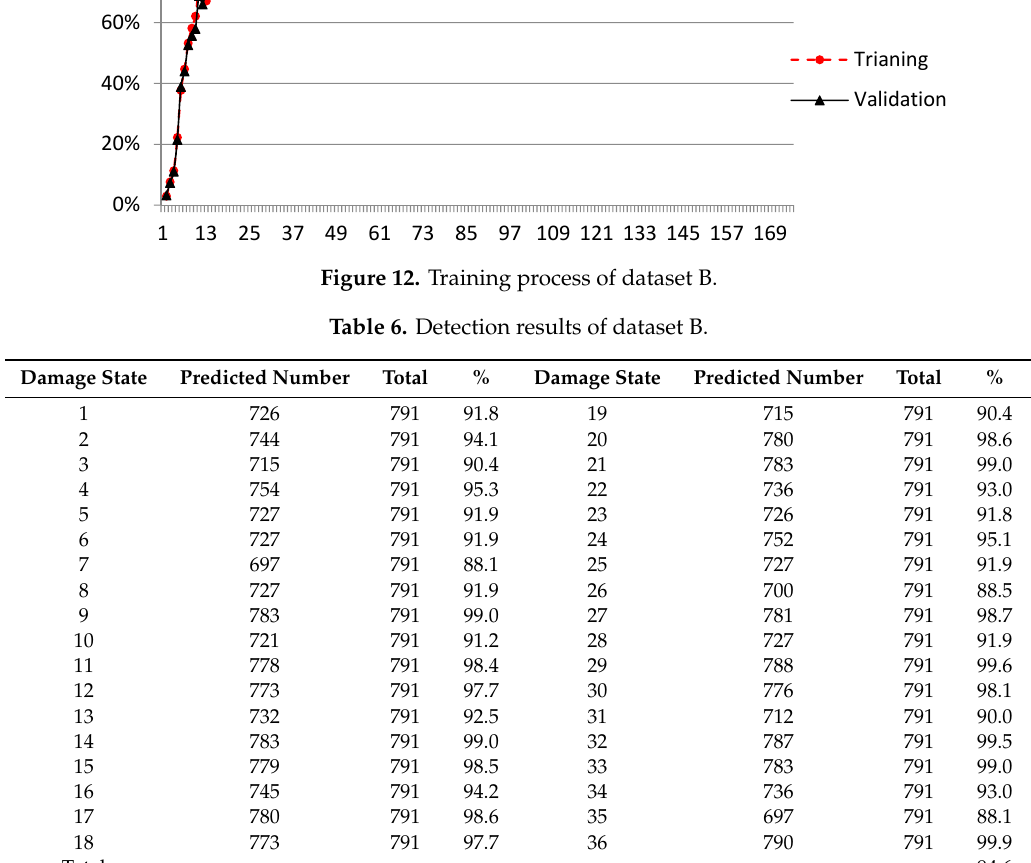
Figure 12. Training process of dataset B. Table 6. Detection results of dataset B.